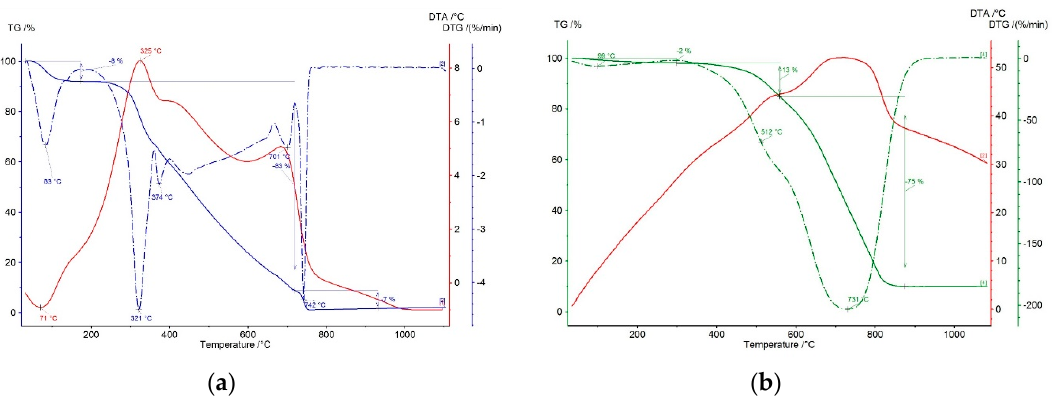
Figure 7. Thermogravimetric analysis of lignin pellets ( a ) and coke breeze ( b ).